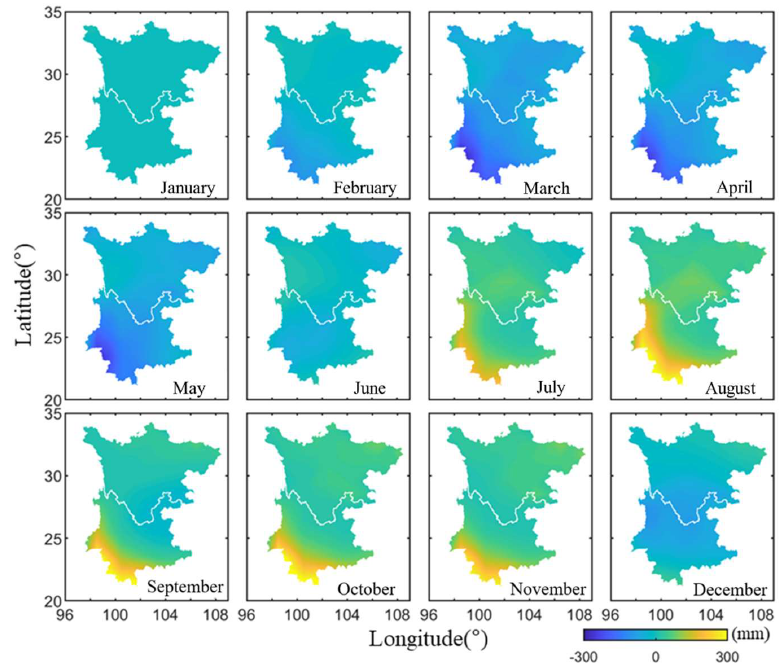
Figure 8. Monthly variations (2011) of the TWS in Sichuan-Yunnan estimated by GRACE.